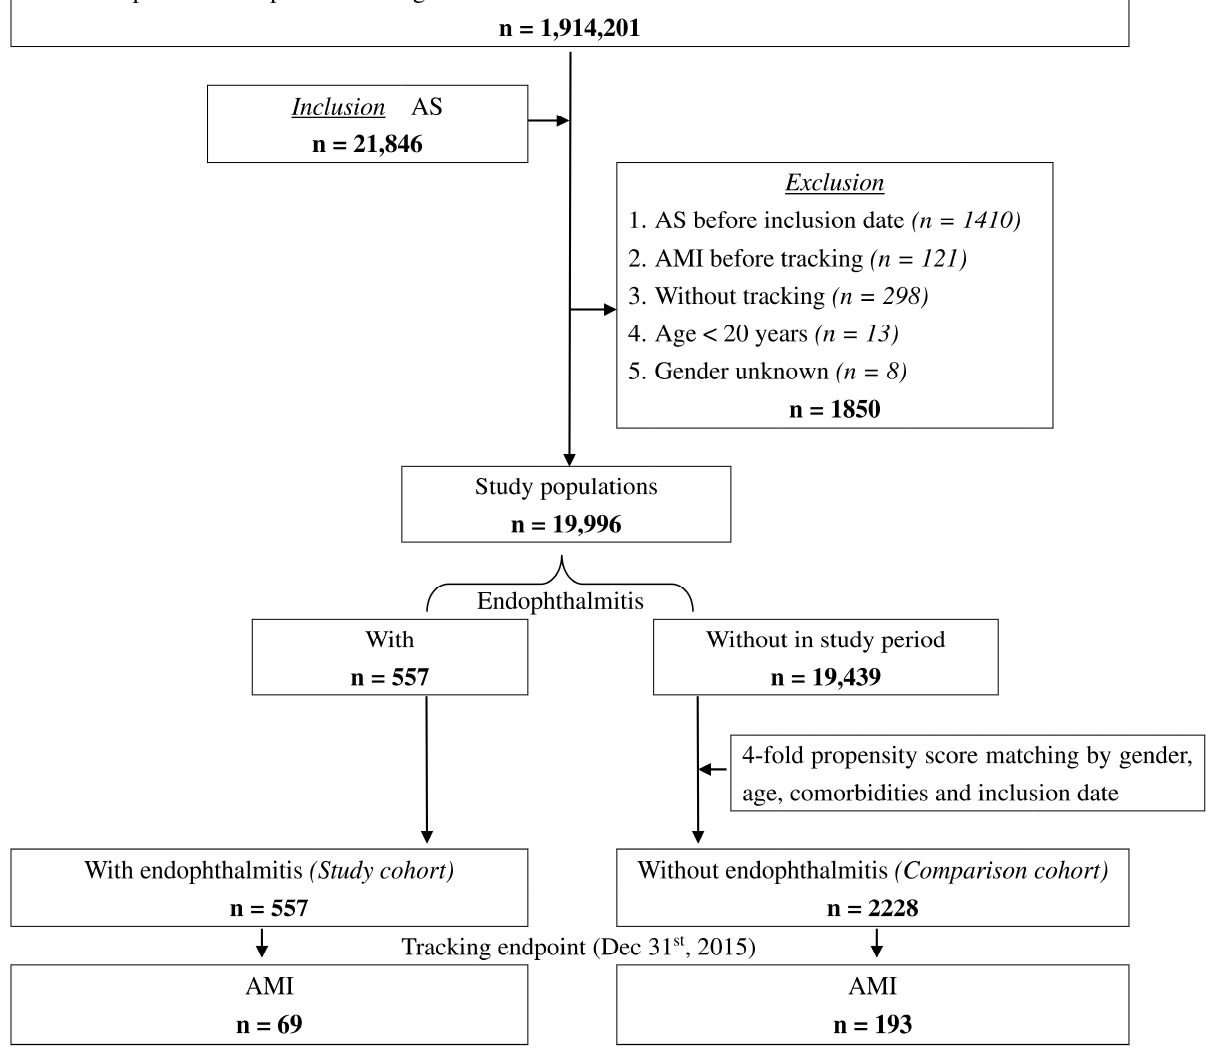
Figure 1. Flowchart of the patient selection in this cohort. Table 1. Demographic and medical characteristics of enrolled AS patients with and without endoph- thalmitis at the endpoint of the